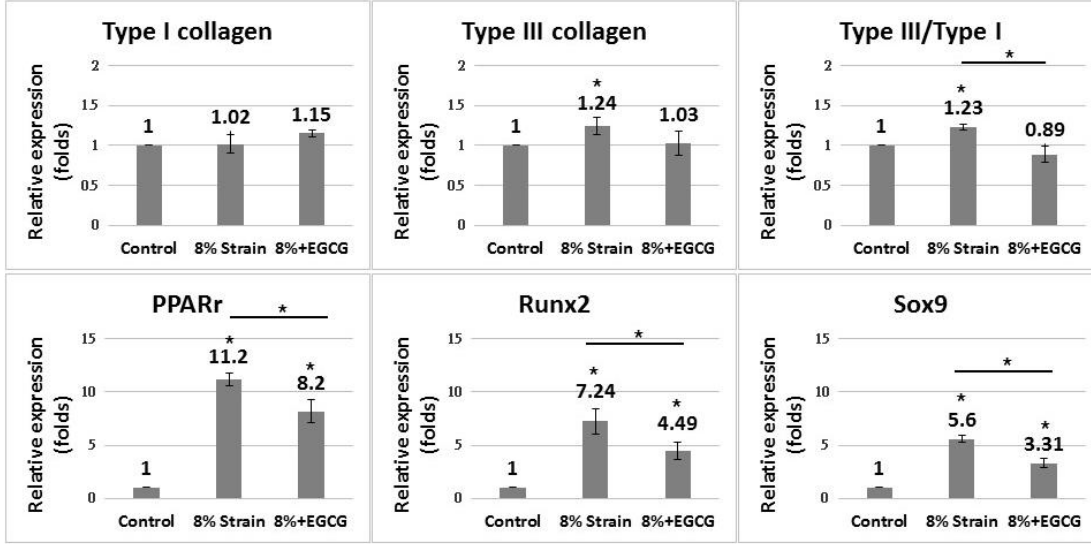
Figure 3. Effect of EGCG on the gene expression of tendon-derived cells (TDCs) subjected to cyclic stretching with 8% strain. Upper panel : Quantitative PCR demonstrated that TDCs with EGCG showed decreased expression of type III / type I collagen genes compared with cells without EGCG. Lower panel : TDCs with EGCG showed decreased expression of Pparg , Runx2 , and Sox9 compared with cells without EGCG. Data are expressed in fold-changes of expression level relative to the control (static culture) presented as mean ± SD ( n = 4, * p < 0.05).